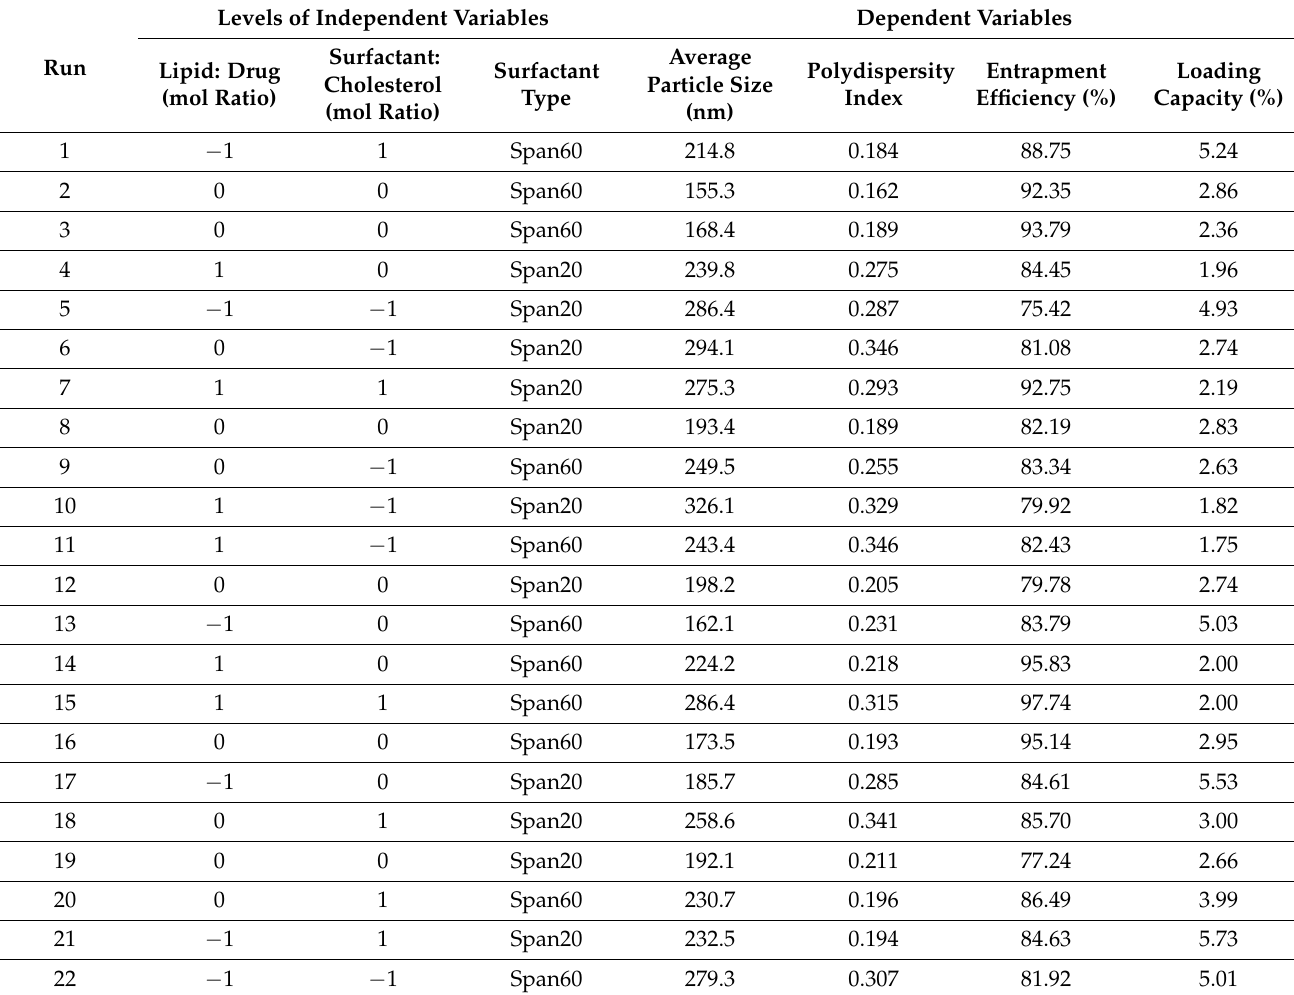
Table 1. Design of the experiment based on response surface methodology for the optimization of cyclophosphamide-loaded niosomes and the corresponding